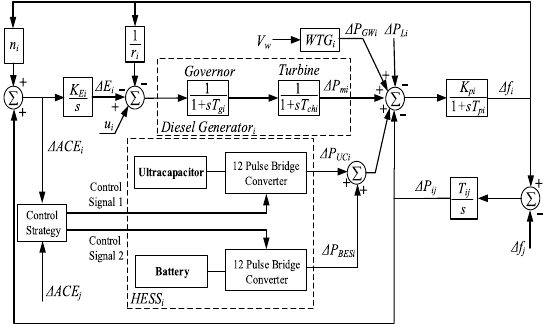
Fig. 2 The i th transfer function model of the wind-diesel